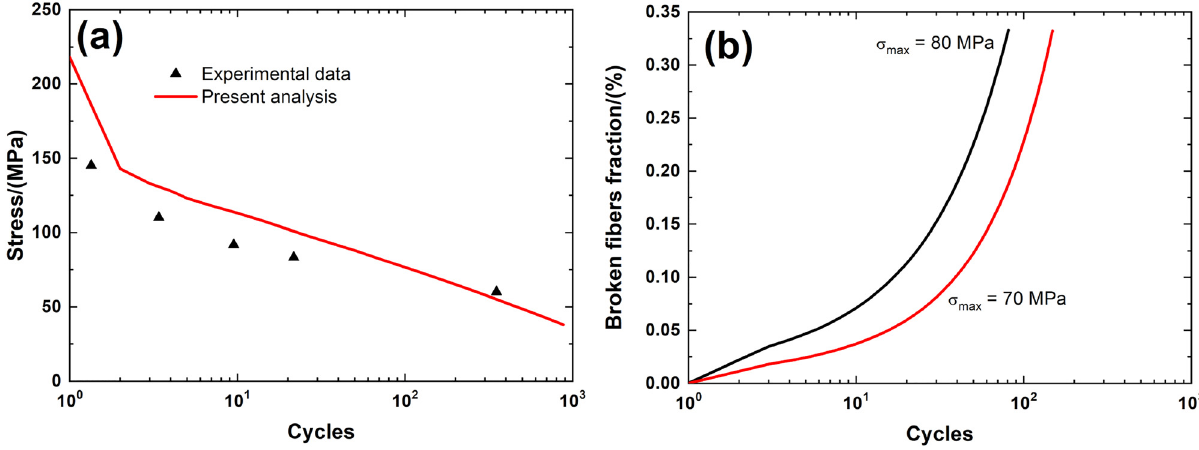
Figure 7: ( a ) Experimental and predicted fatigue life S – N curves, and ( b ) the FBFF versus applied cycles of cross - ply SiC/MAS composite under OP - TMF